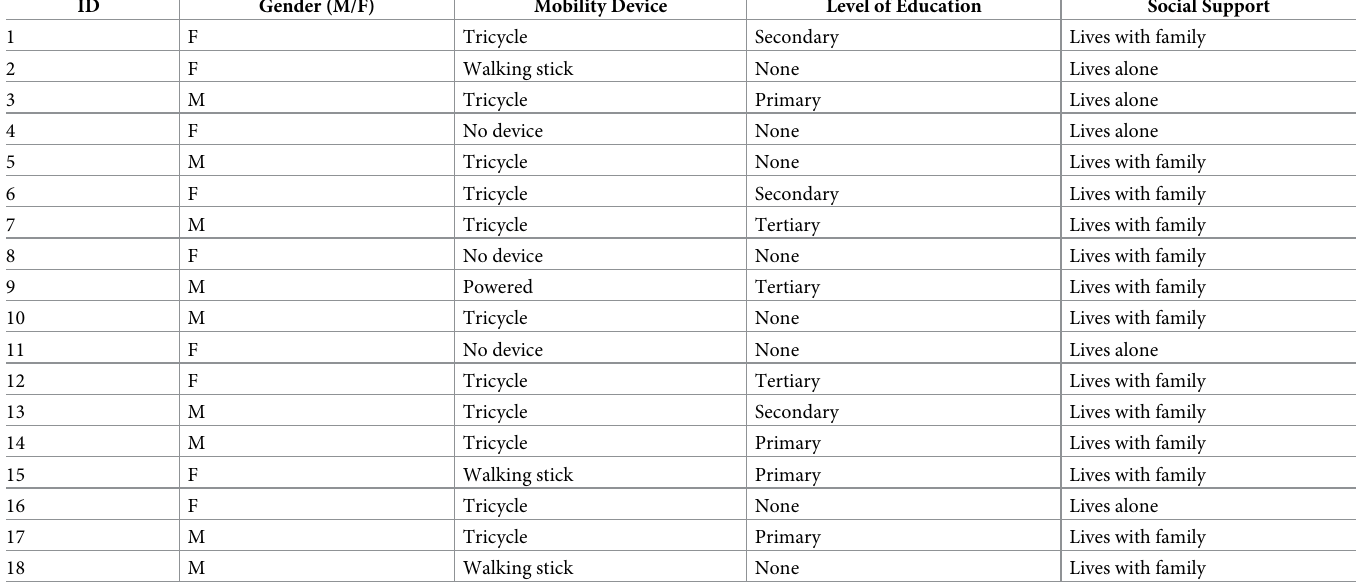
Table 1. Demographics of persons with physical